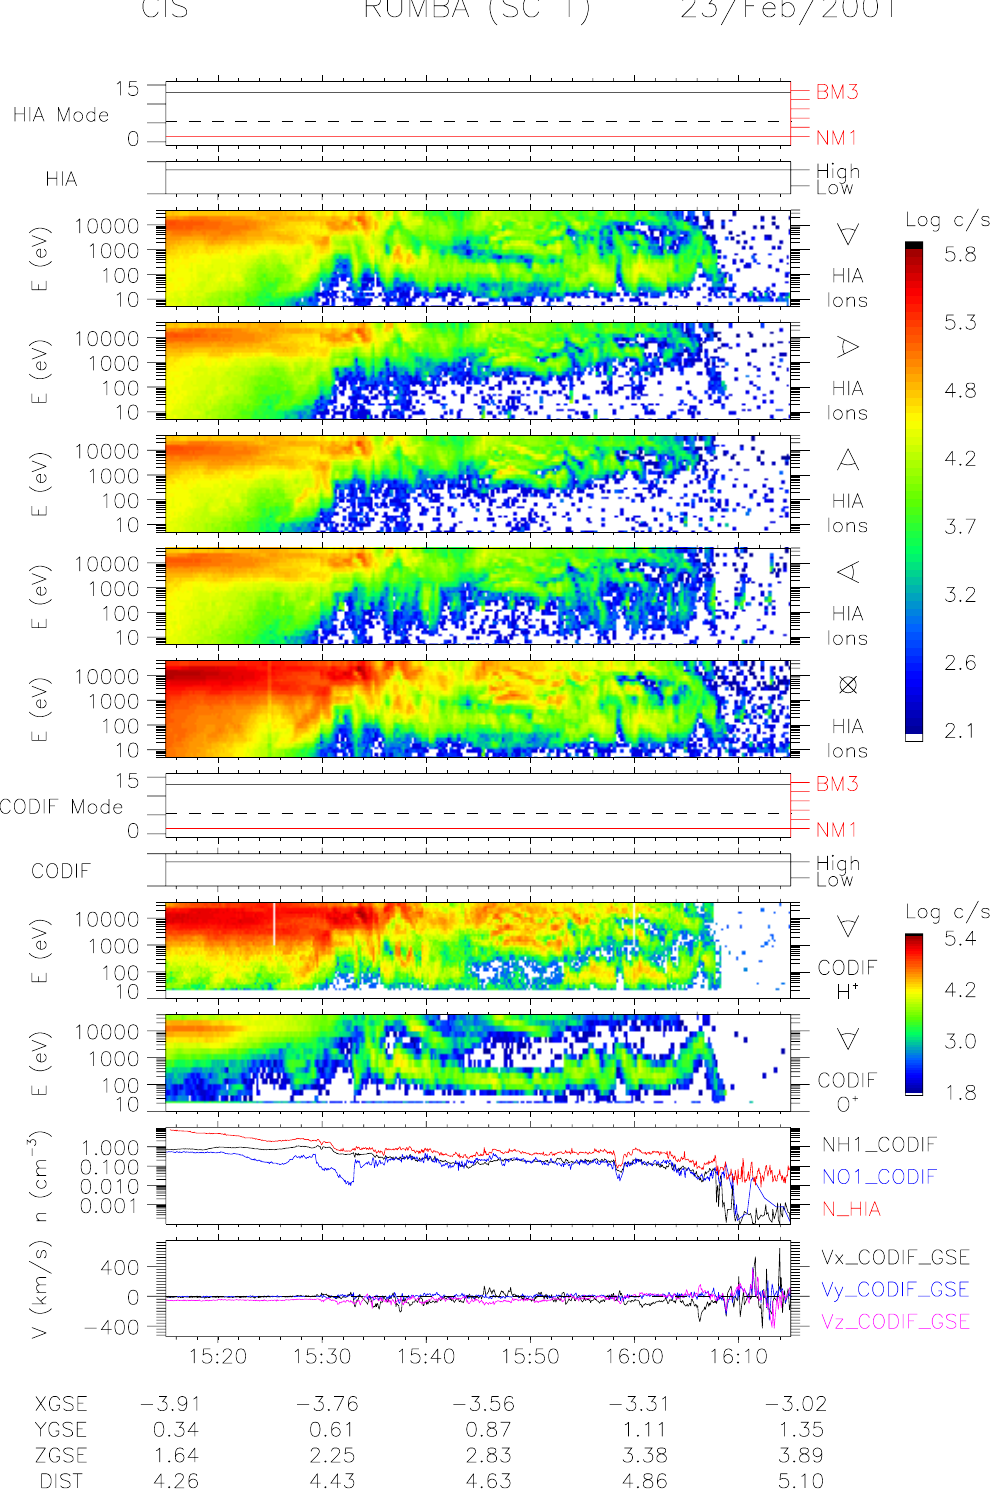
Fig. 37. Traversal of the auroral region by spacecraft 1 on 23 February 2001, as seen by HIA and CODIF between 15:15 and 16:15UT. HIA measurements (upper panel) give telemetry modes and sensitivities, energy-time spectrograms measured in the sunward, dusk, anti-sunward, dawnward looking directions and energy-time spectrogram integrated over 4 5 ; CODIF measurements (lower panel) give telemetry modes and sensitivities, energy-time spectrogram for upflowing H + and O + ions, HIA, CODIF H + and O + densities and GSE velocity